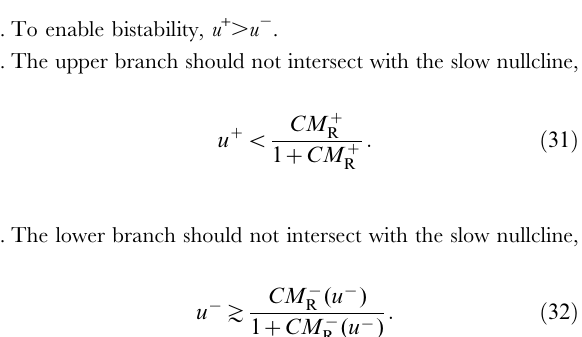
Figure S1 Effects of firing rate saturation. M R - I R curves (top panel) and M L - I R curves (bottom panel) are plotted for g RL = 0 (black) and 35 (red). Solid line: M i values are calculated according to Equation S1; dotted line: M i values are calculated according to Equations 4–6. Additional parameters are g RL =35, g LR =7.5,